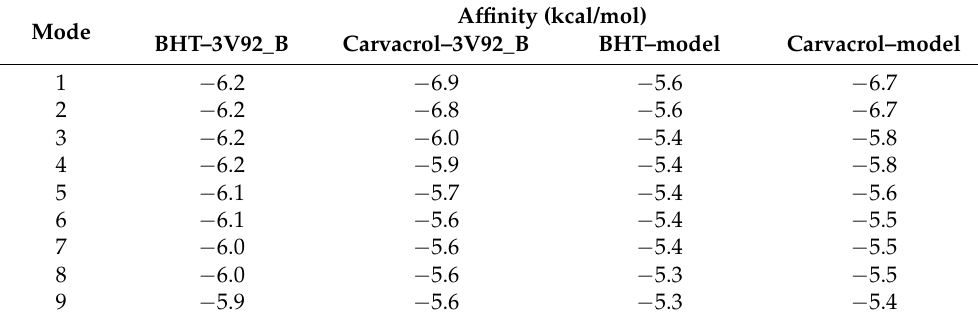
Table 2. Binding affinity for docked poses using AutoDock Vina.